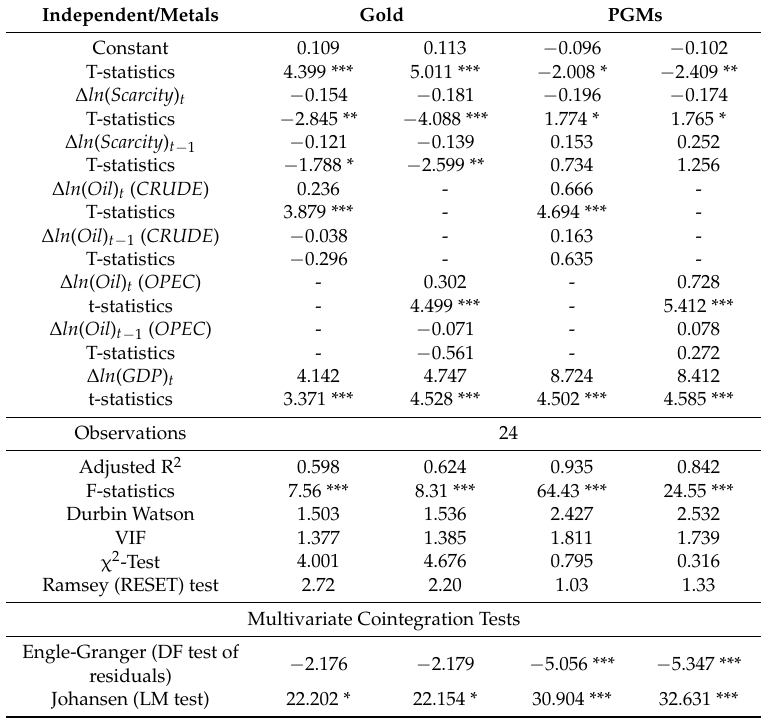
Table 2. The regression results of Equation (2) for PGMs and Gold,